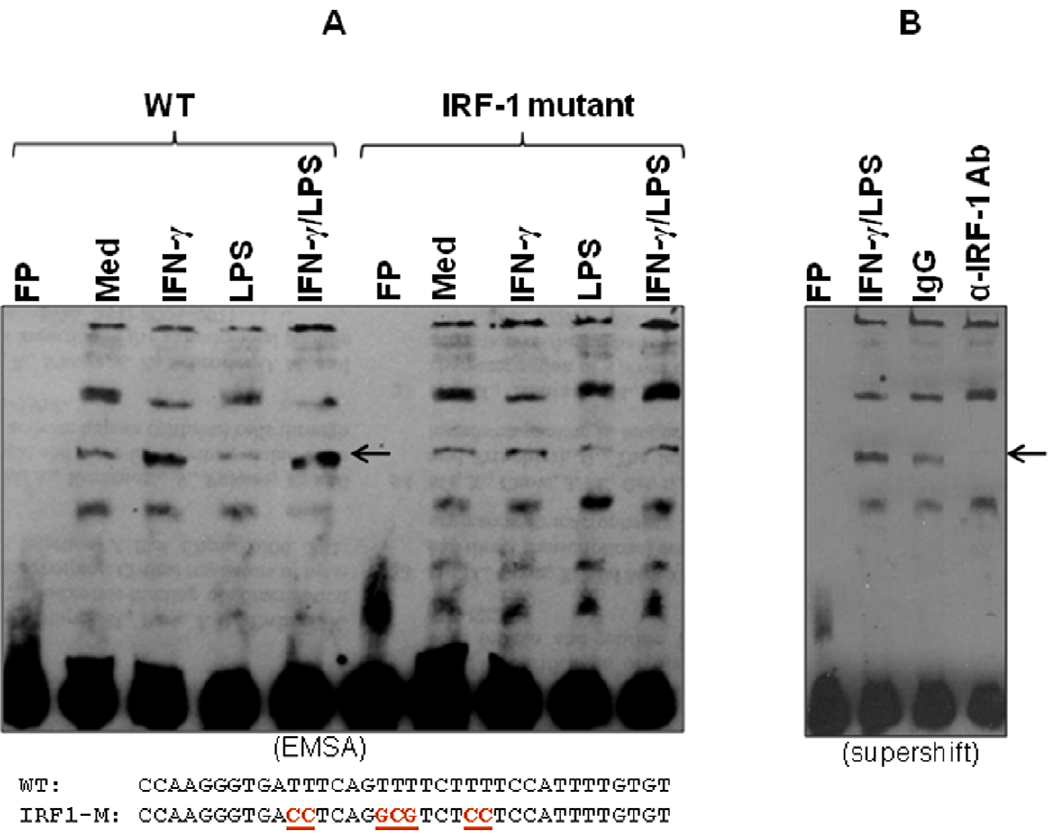
Figure 4. IRF-1 specifically binds to the CCL5 promoter. (A) Nuclear extracts were isolated from A7r5 cells following IFN- c or LPS stimulation for 4 h. EMSA was performed with 10 m g of nuclear extract for each sample and a double-stranded oligonucleotide probe containing the 2 161/ 2 134 region of the CCL5 promoter (sequence given with the critical IRF-RE underlined). (B) ‘‘Supershift’’ EMSA was performed with the 2 161/ 2 134 probe and nuclear extracts from IFN c /LPS-stimulated macrophages with an anti IRF-1 antibody and its control rabbit IgG being used. The IRF-1-related complex is indicated by an arrow.